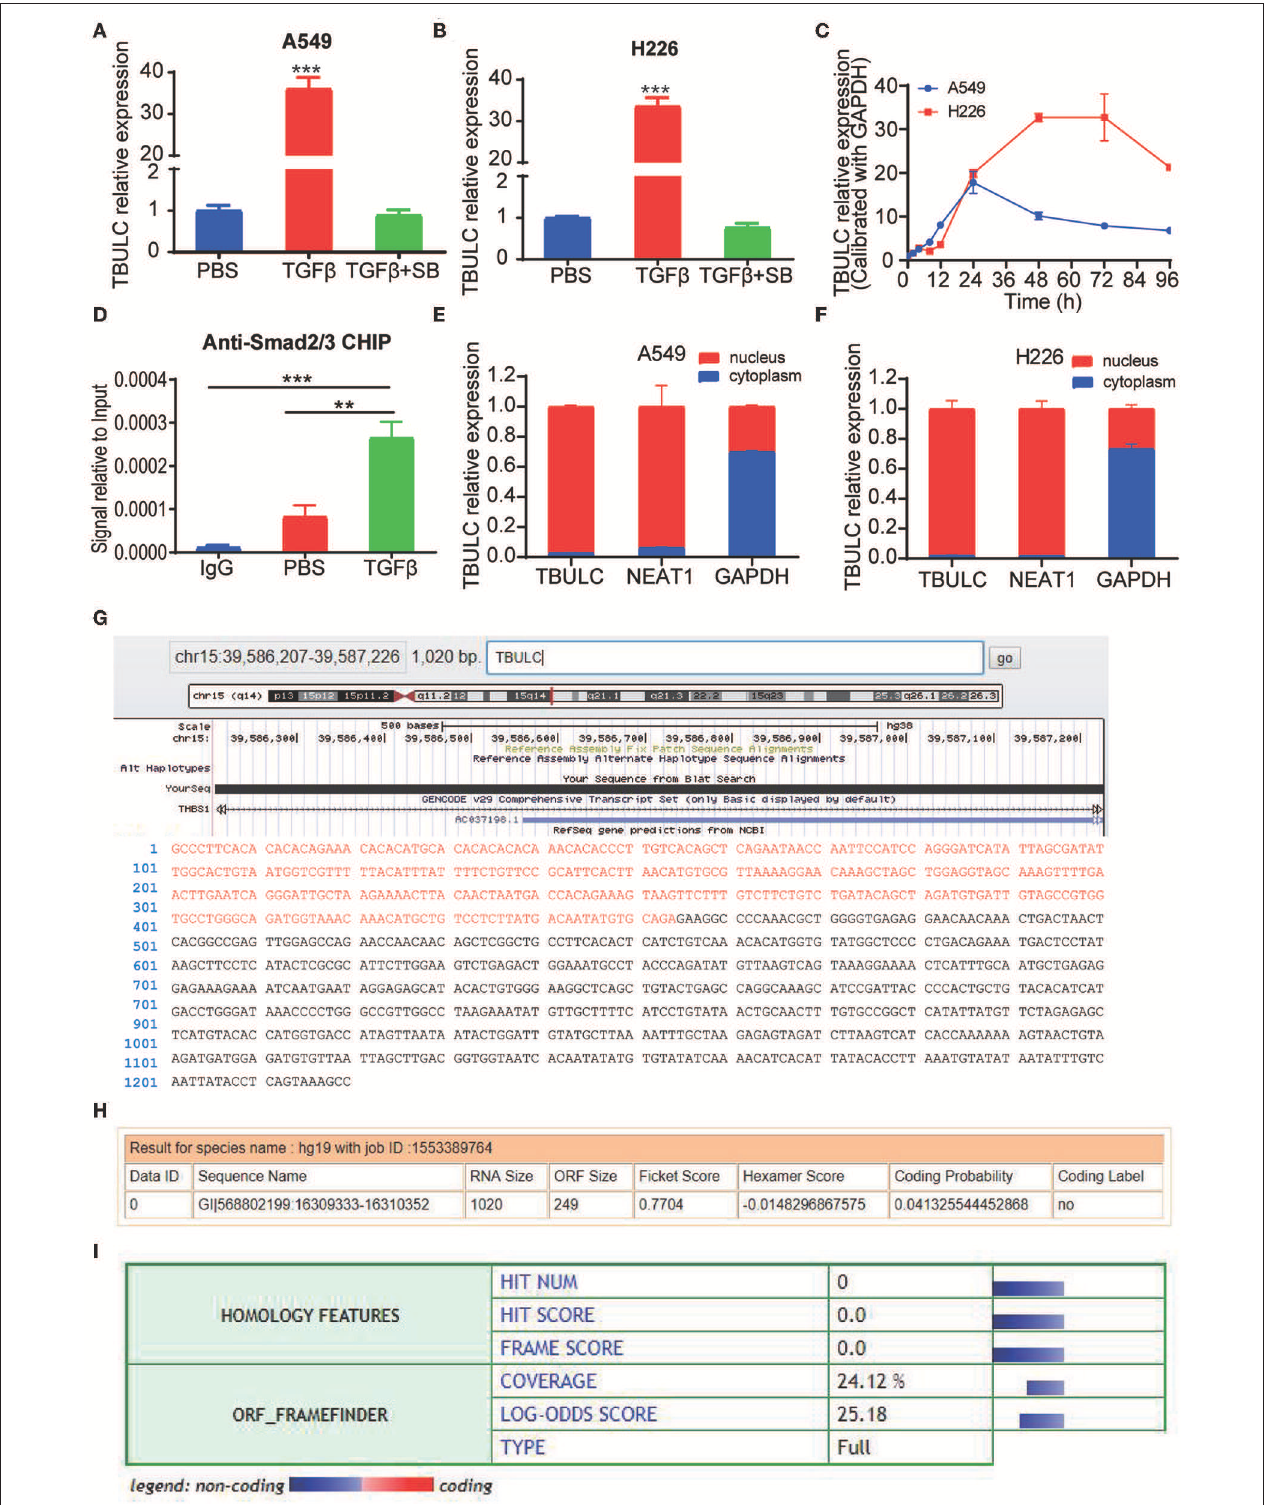
FIGURE 1 | TBULC was upregulated by the classic TGF- β pathway. (A,B) Relative expression levels of TBULC in cancer cell lines (A) A549and (B) H226 treated with phosphate-buffered saline (PBS), TGF- β 1, or TGF- β 1 plus the TGF- β inhibitor SB505124 (SB), as measured by RT-qPCR. (C) Relative expression levels of TBULC